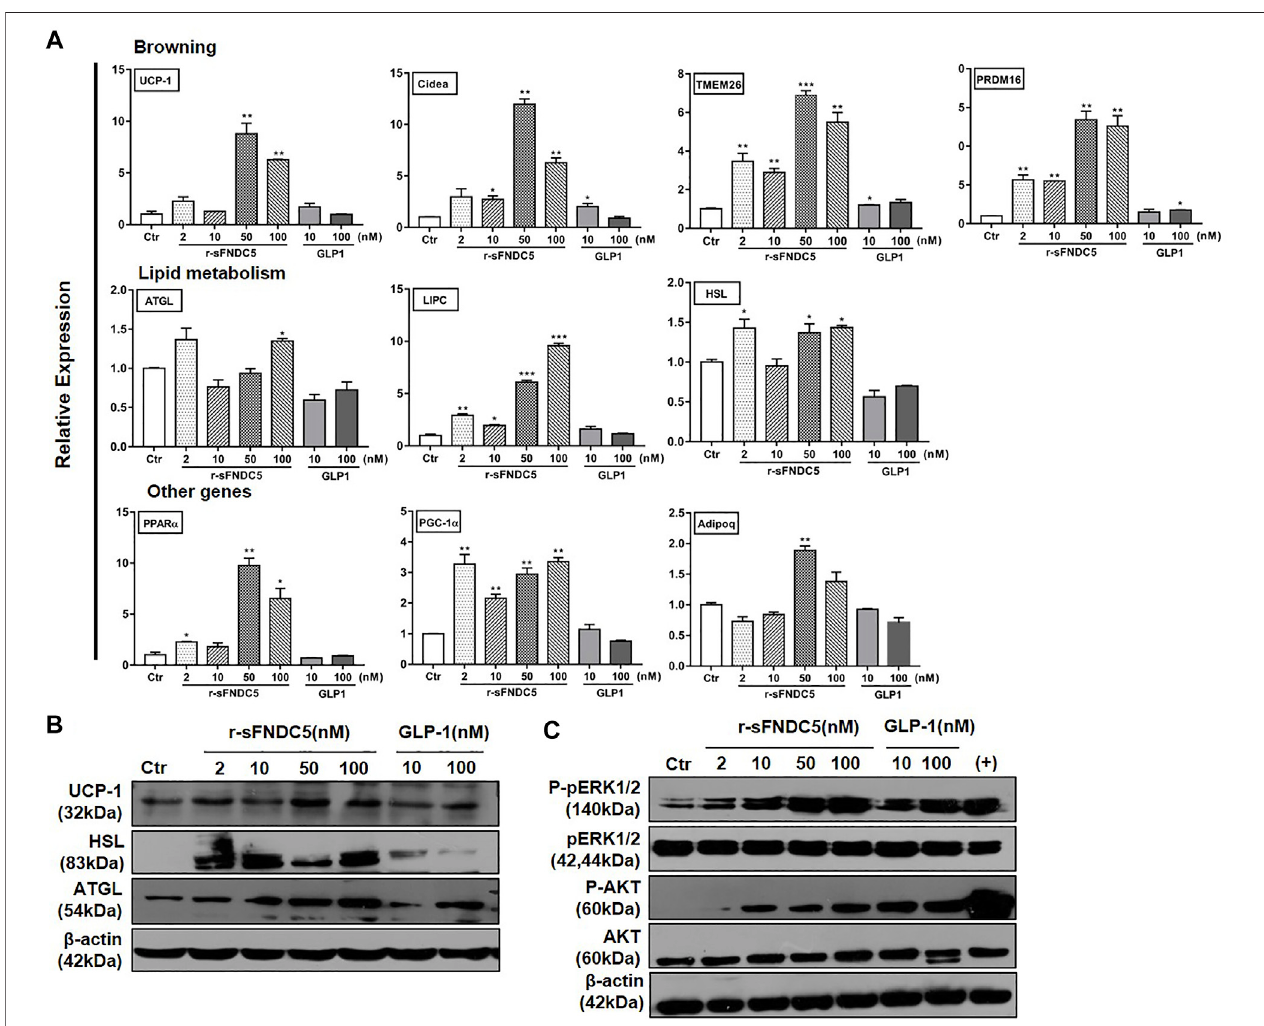
FIGURE 5 | The anti-obesity activities of GLP-1 and sFNDC5 in mature 3T3-L1 adipocytes. (A) Upregulated expression of selected biomarker genes of browning, lipolysis, and other programs in fully differentiated, mature 3T3-L1 adipocytes by r-sFNDC5 and GLP-1. The cells were treated with r-sFNDC5 and GLP-1 at indicated concentrationsfor24 h( n (cid:1) 3).Untreated cellsservedasthecontrolfornormalizingthesignals. (B) Upregulatedexpression ofUCP-1,HSL,andATGLinmature3T3-L1 adipocytes by r-sFNDC5 and GLP-1 at indicated concentrations. Cells were treated with r-sFNDC5 and GLP-1 for 24 h ( n (cid:1) 3). Untreated cells served as control. β -Actin expression was used as a control in western blotting analysis. (C) Activation of ERK1/2 and AKT in mature 3T3-L1 adipocytes by r-sFNDC5 and GLP-1 at indicated concentrations. Cells were treated with r-sFNDC5 and GLP-1 for 24 h ( n (cid:1) 3). Untreated cells served as control. β -Actin expression was used as a control in western blotting analysis. Values are mean ± SEM. * p < 0.05, ** p < 0.01 and *** p < 0.001.